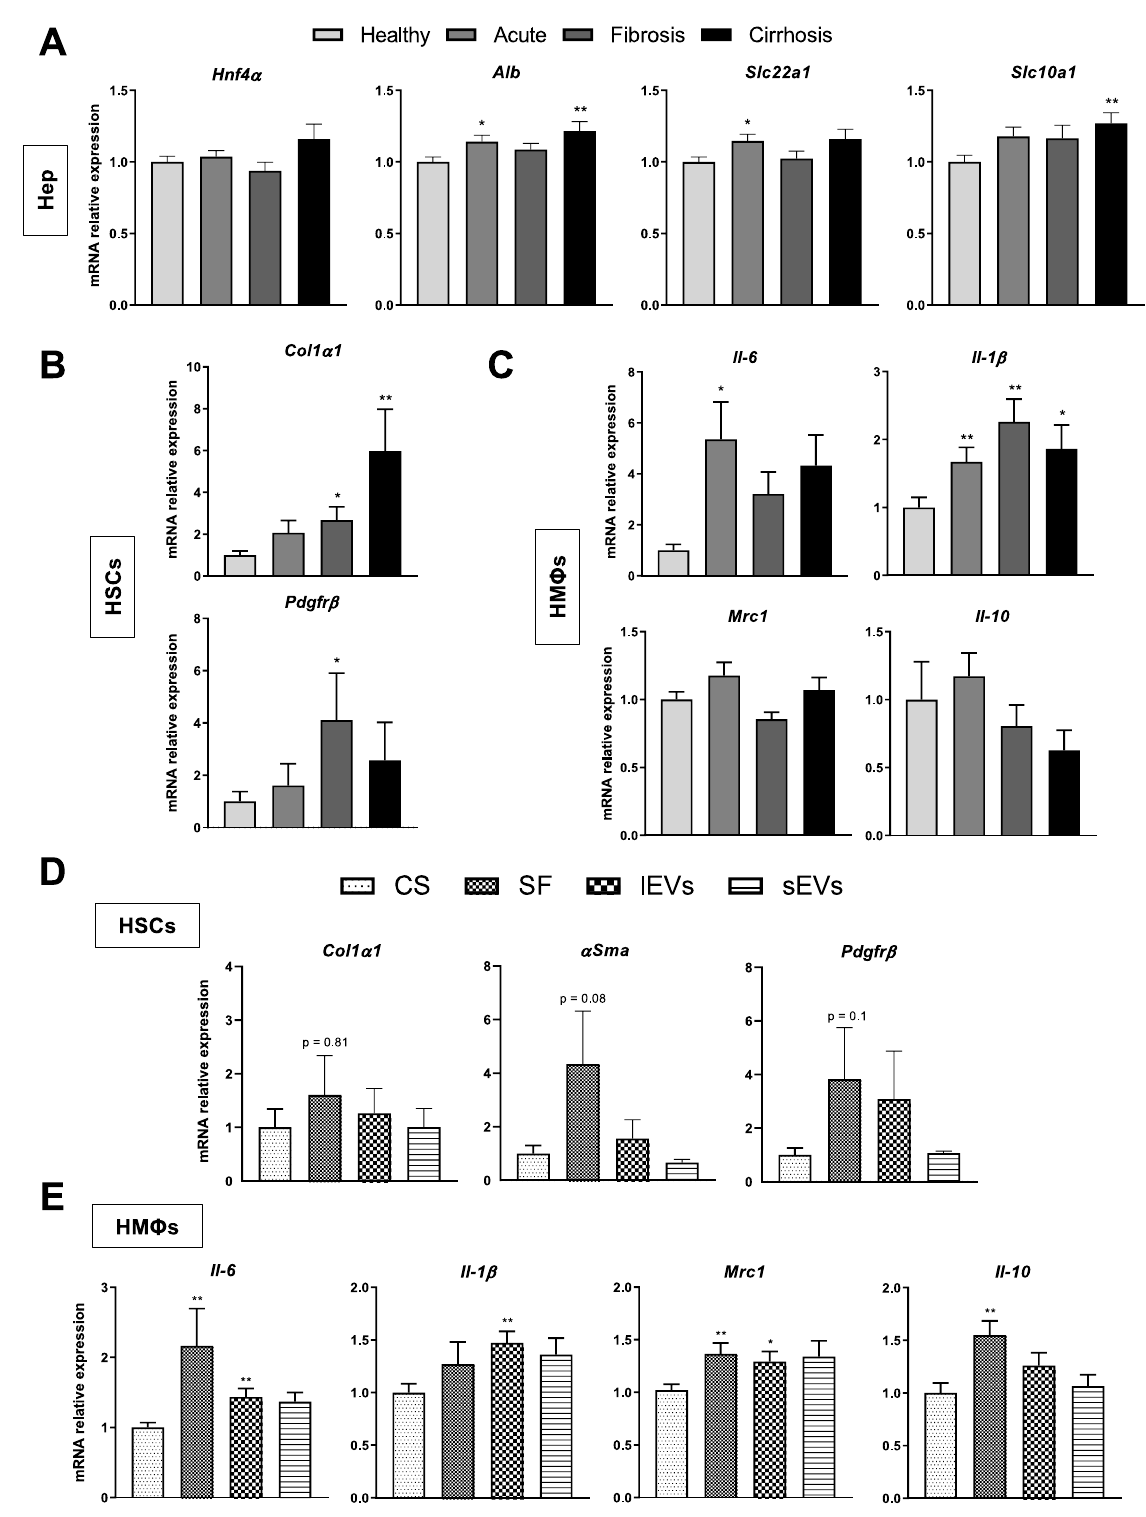
Figure 4. Effects of LSECs secretome on neighbouring liver cells during CLD. mRNA expression of specific phenotype markers in hepatocytes (A), HSCs (B) and HM Φ s (C) incubated for 24 h with the complete secretome (CS) of LSECs isolated at each stage of CLD. mRNA expression of phenotype markers in HSCs (D) and HM Φ s (E) after 24 h of incubation with the different sub-fractions of cirrhotic LSECs secretome: large extracellular vesicles (lEVs), small EVs (sEVs) and soluble factors (SF), normalized to CS-receiving cells. Results derive from n = 3–5 independent experiments. * p < 0.05 and ** p < 0.01 on t test (Mann-Whitney U test for non-parametric variables) for differences between each group and the CS group.